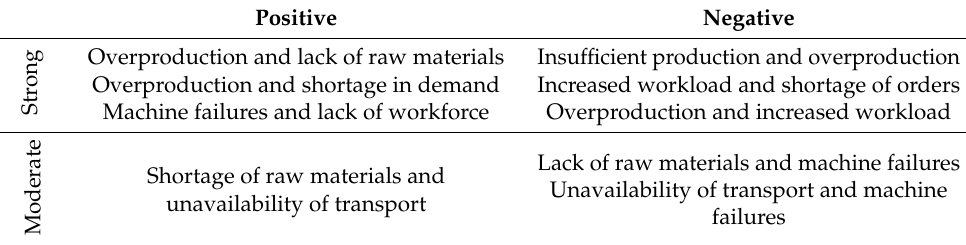
Table 2. Correlations among aspects of operational activities.